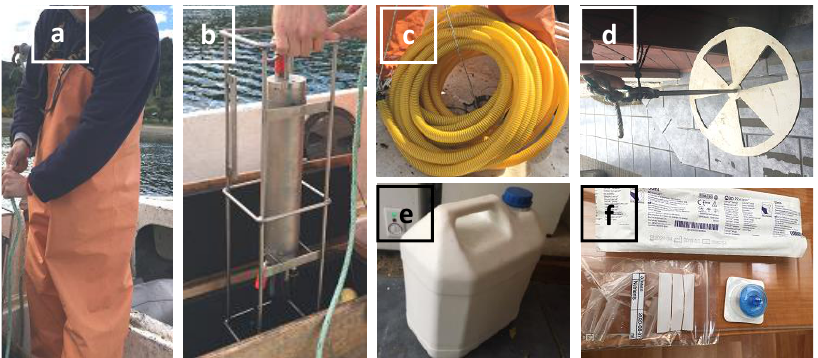
Figure 1. Materials and devices to carry to sampling sites: ( a ) fisherman’s waders and water-proof shoes, ( b ) CTD, ( c ) a 10-cm diameter with 10-m length siphoning hose with twisting lock on top and bottom, ( d ) Secchi disc, ( e ) a pre-cleaned 10-L plastic container, ( f ) sterile 50-mL syringe, 0.22 μm pore size filter, 5 × 2-mL sterile tubes, labeled bag and tubes with date, location, and sample ID.